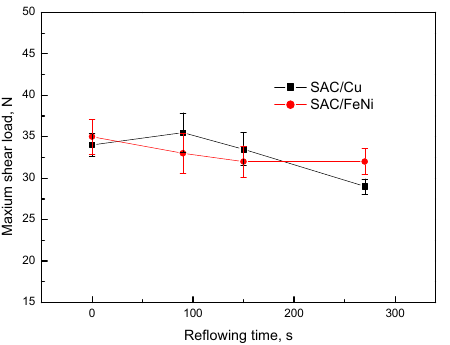
Figure 6. Dependence of the maximum shear force on the reflowing time for the SAC/Cu and SAC/FeNi ‐ Cu connections.